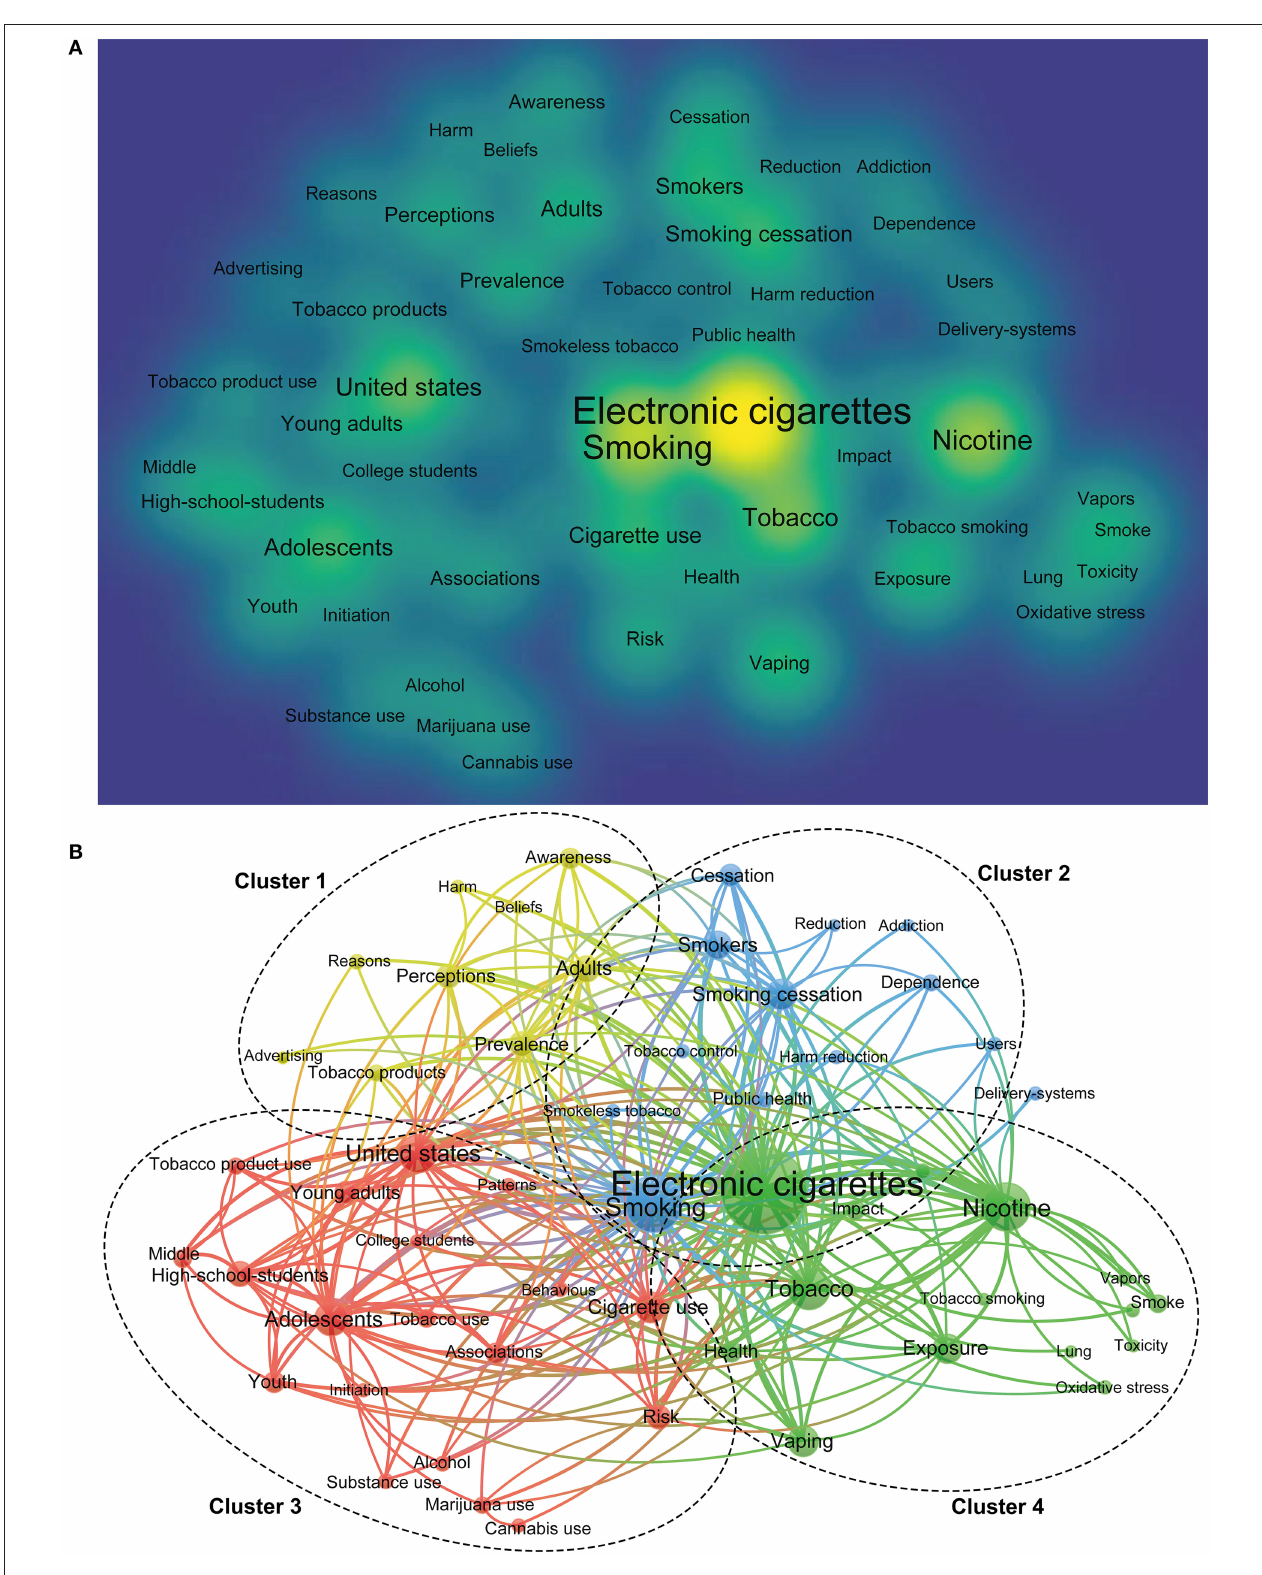
FIGURE 4 | The density map (A) and network map (B) of keywords for e-cigarettes research.